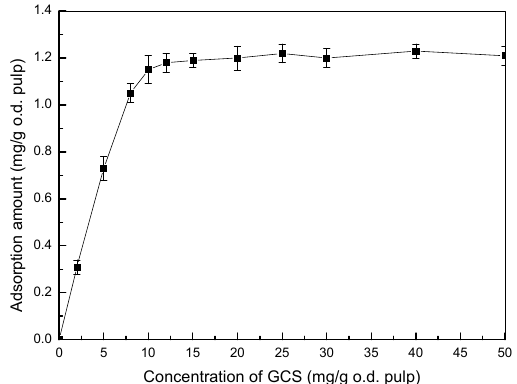
Figure 6. Adsorption of GCS on cellulose fibers (DS of GCS = 25.5%).